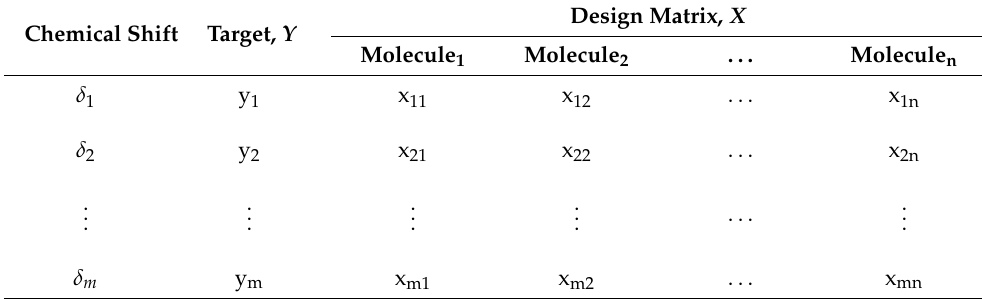
Table 3. Calculation of a target Y and the corresponding design matrix X . Chemical Shift Target, Y